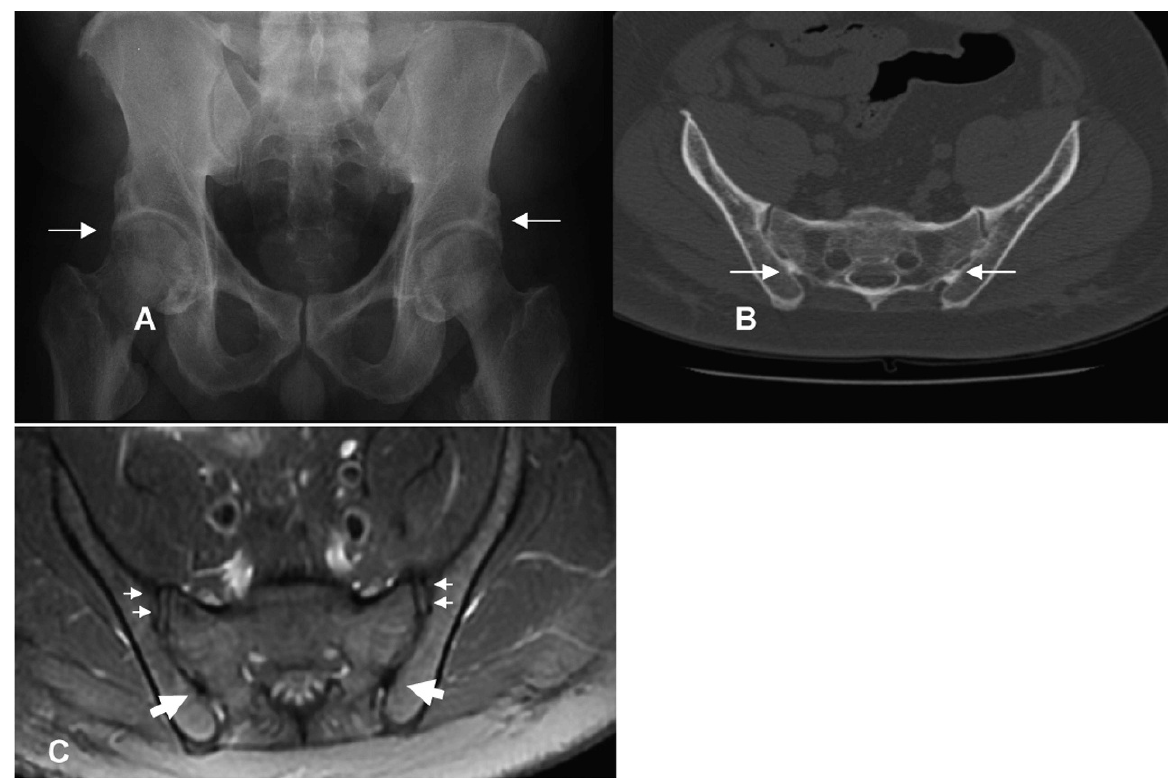
Figure 2 - A- Hip radiograph showing bilateral ossification at the superior acetabular margin (arrows). B- Pelvis CT showing foci of ankylosis in the lower portion of the sacroiliac joint (arrows). C- Axial fat sat T2-weighted turbo spin-echo showing the lower portion of the sacroiliac joint with ossification of the iliosacral ligaments (large arrows). There are no significant findings in the upper portions of the sacroiliac joint (small